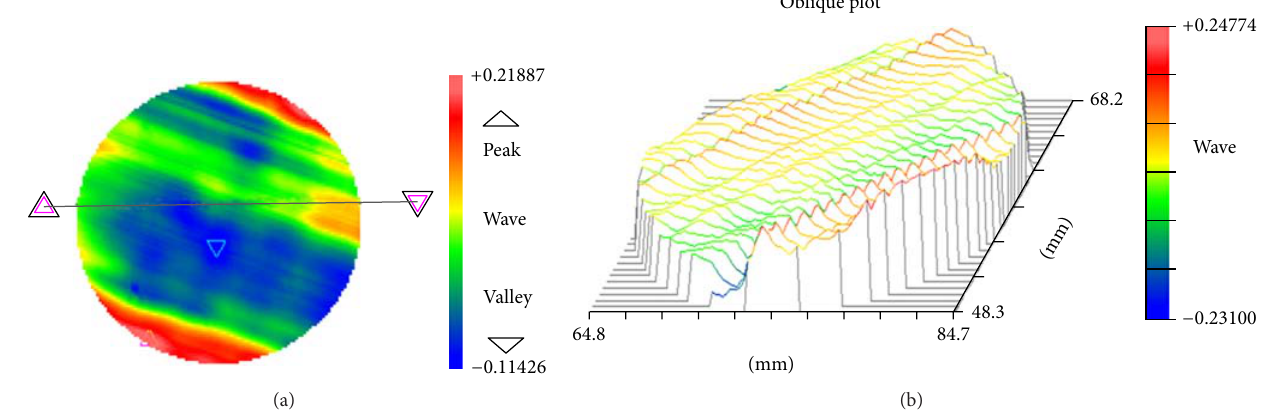
Figure 3: Wavefront distortion after a double pass through FEP film: (a) the aerial view and (b) the three-dimensional graph.